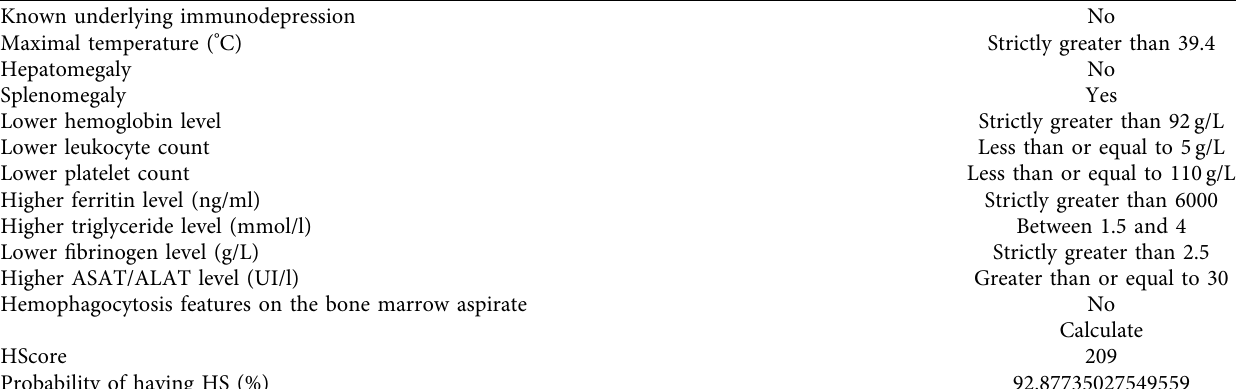
Table 3: Saint-Antoine score [23] calculated for this case